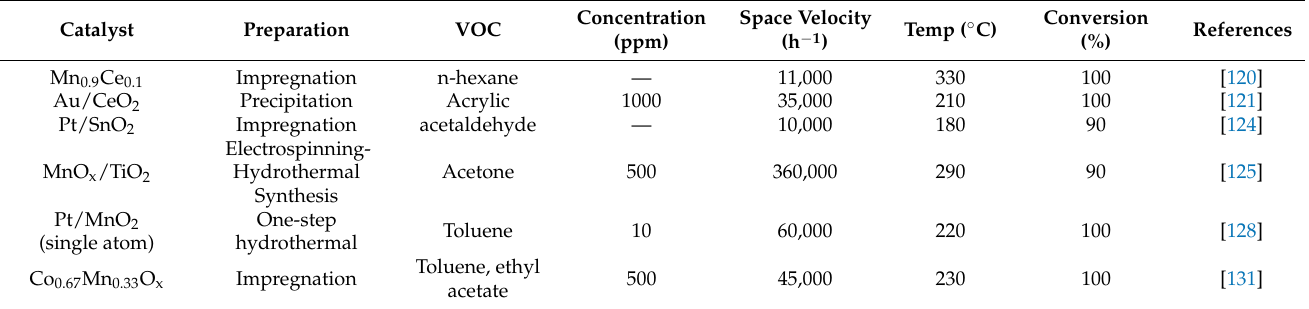
Table 4. Catalytic combustion method for the degradation of different model